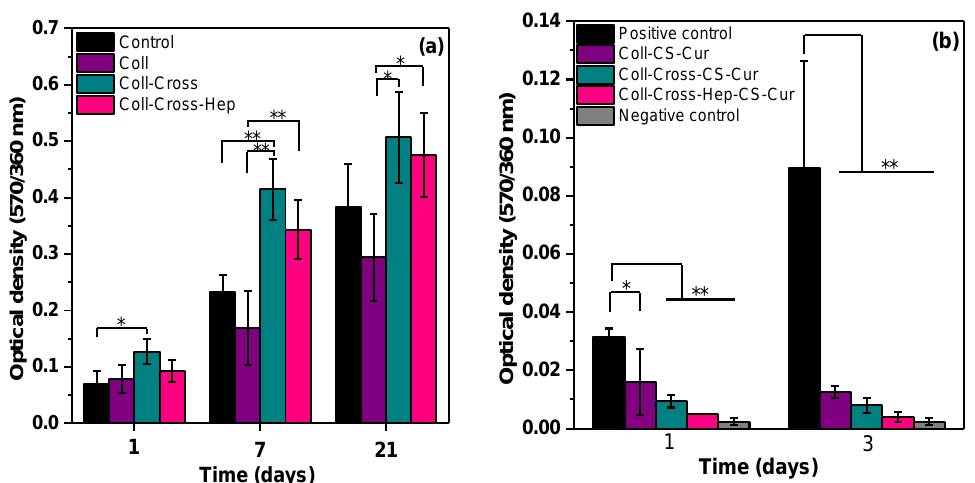
Figure 9. ( a ) MTT assay results on the proliferation of fibroblasts seeded on the Coll patches without Cur. ( b ) MTT assay results on the proliferation of psoriatic keratinocytes seeded on the Coll patches with Cur. Mean ± SD. * p < 0.05, ** p < 0.01.